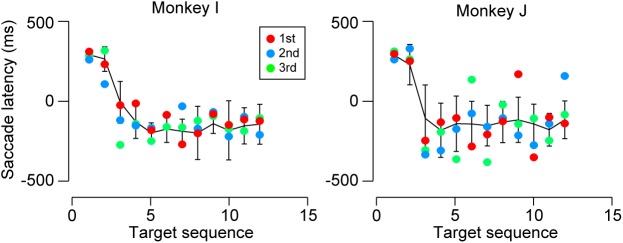
Saccade latencies for 1200-ms SOA during the first test session. Colored dots indicate the data for the initial three trials. Black lines connect the means of subsequent saccade latencies as a function of target sequence location in the same session. Error bars denote ± SD. Note that both monkeys generated predictive saccades for the novel stimulus sequence during the very first trials.